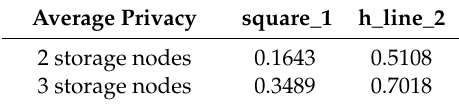
Table 1. Average privacy achieved by the walkthrough algorithm for the topology of 37 nodes.